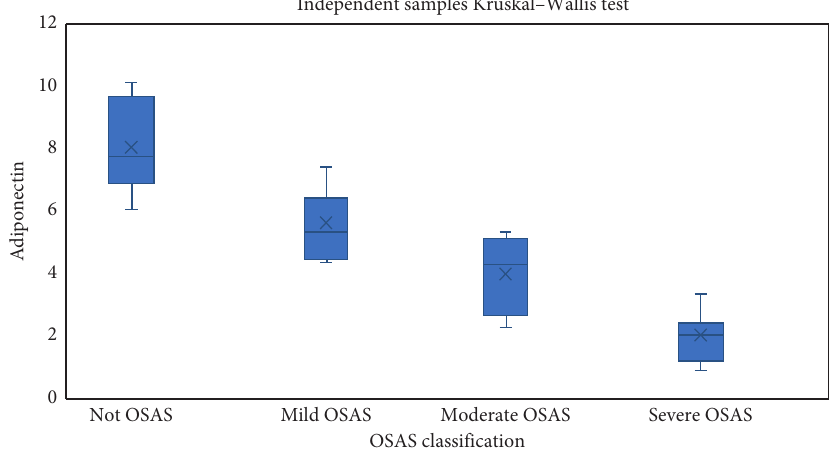
Figure 1: Distribution of adiponectin values according to OSAS classes.